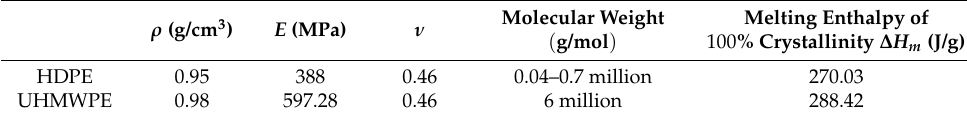
Table 1. Material